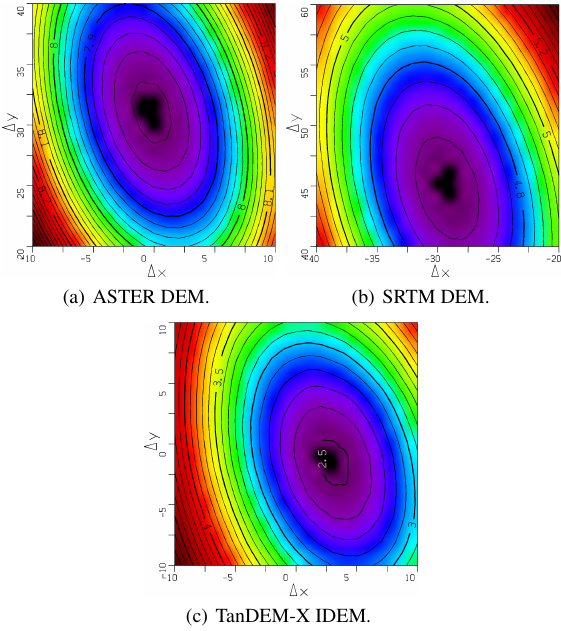
Figure 4. Psarrou study site. Elevation RMSE with respect to planar translation (DX,